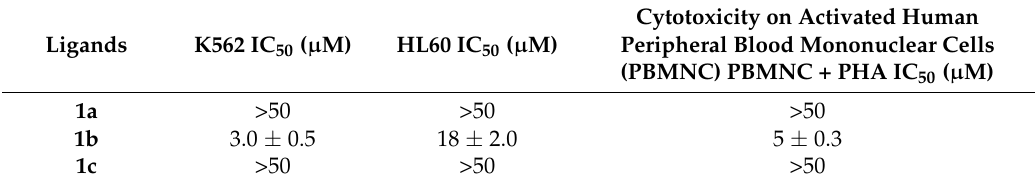
Table 4. In vitro sensitivity of compounds 1a – c on two human myeloid leukaemia cell lines, and cytotoxicity on human peripheral blood mononuclear cells PBMNC +